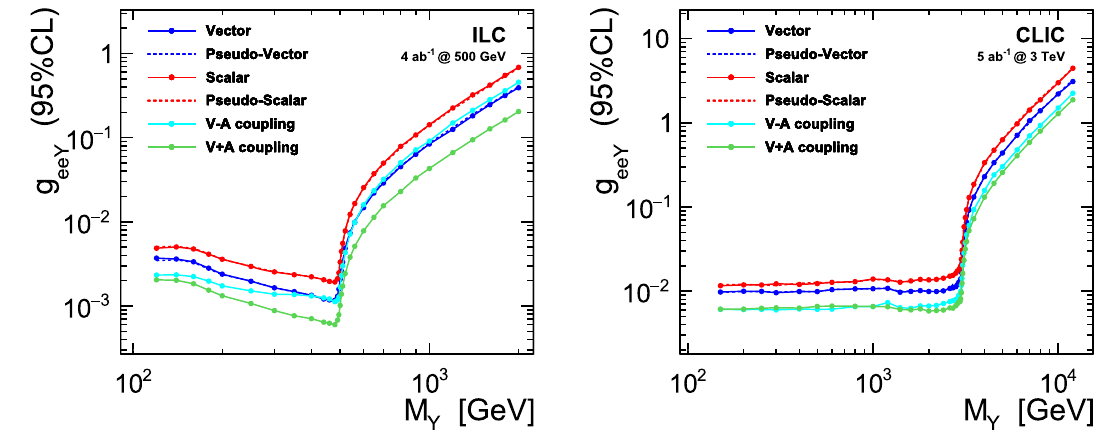
Fig. 15 Limits on mediator coupling to electrons for the ILC running at 500GeV (left) and CLIC running at 3TeV (right), for relative mediator width, (cid:4)/ M = 0 . 03, and different mediator coupling scenarios, as indicated in the plot. Combined limits corresponding to the assumed running scenarios are presented with systematic uncertainties taken into